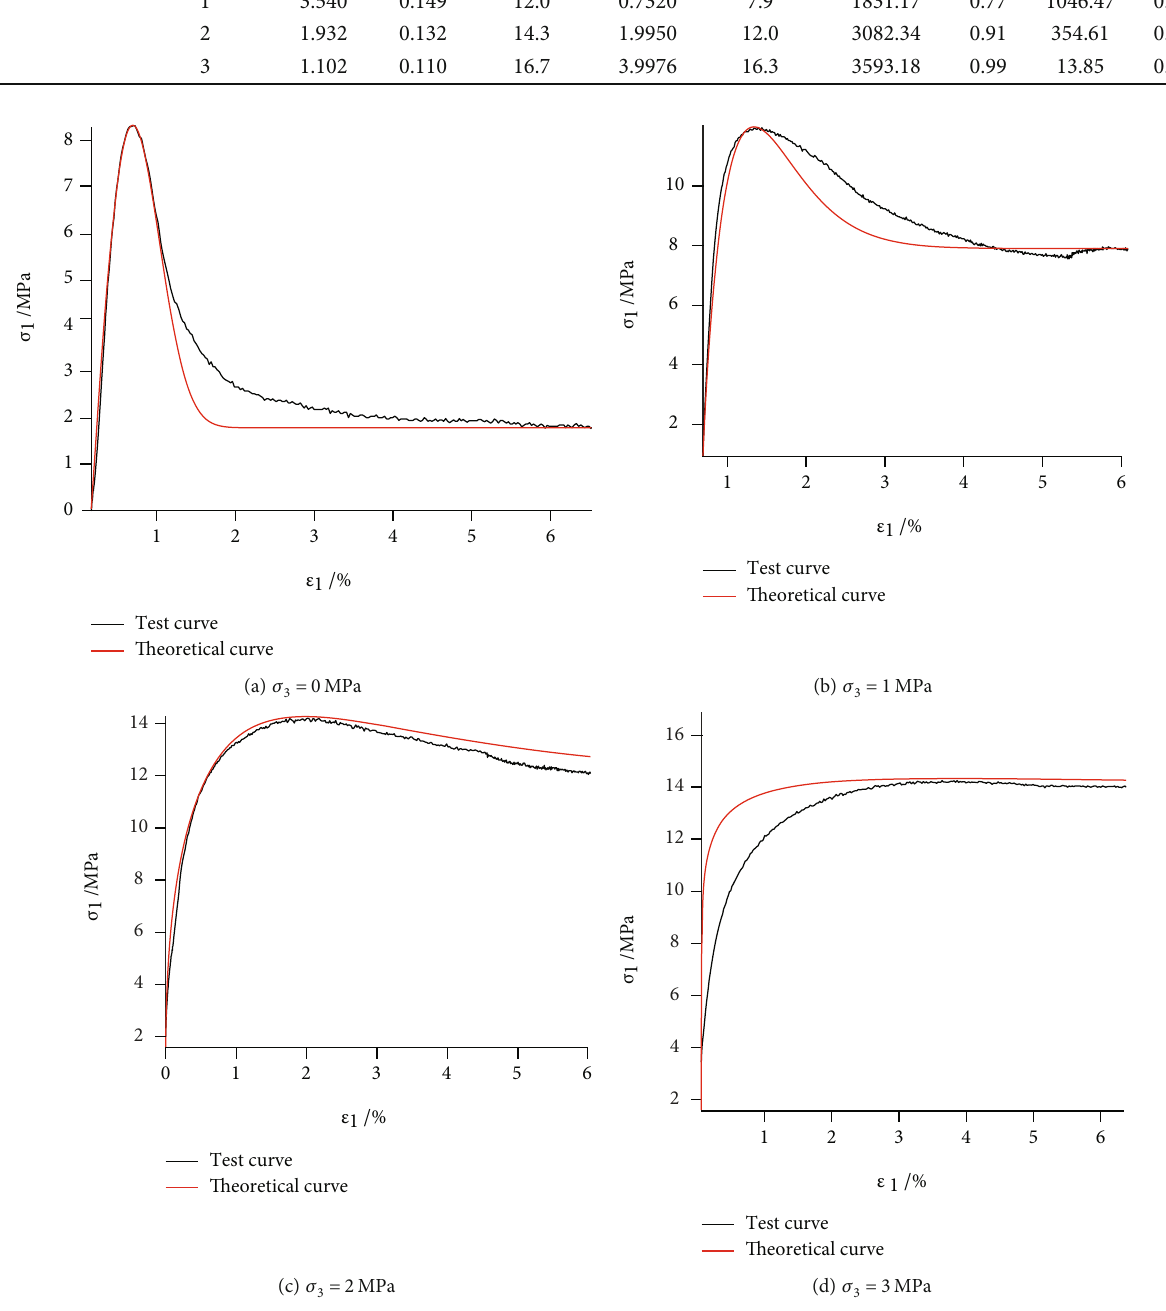
Figure 4: Damage constitutive